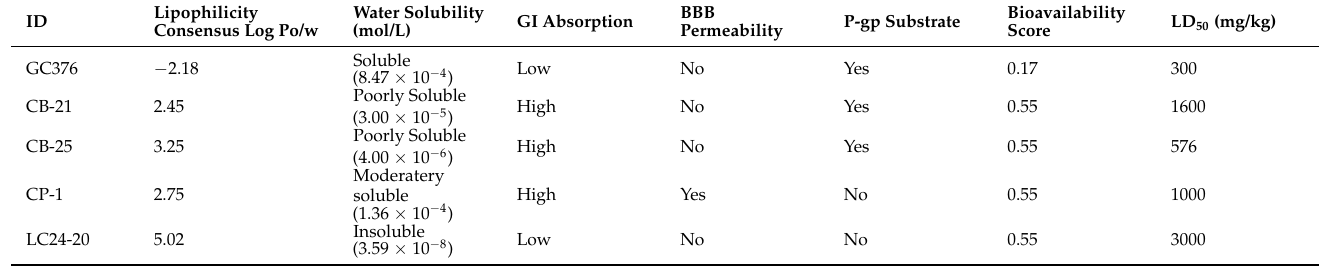
Table 2. Drug likeliness, pharmacokinetic and oral toxicity evaluations of selected